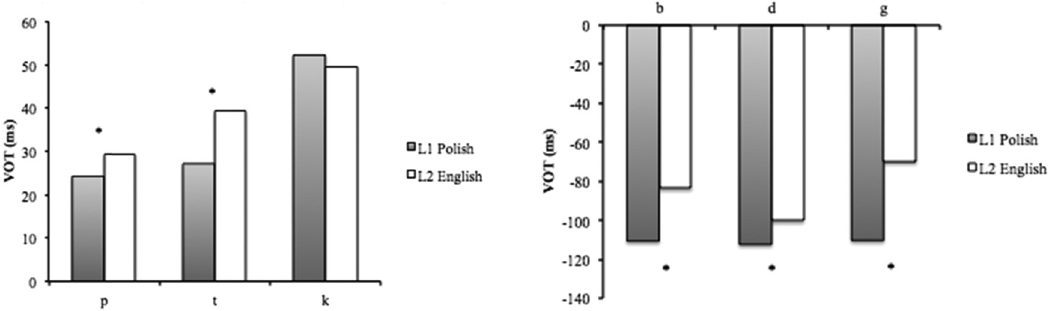
Figure 1: L1 Polish stops compared to L2 English stops ( left – voiceless stops; right – voiced stops ) .